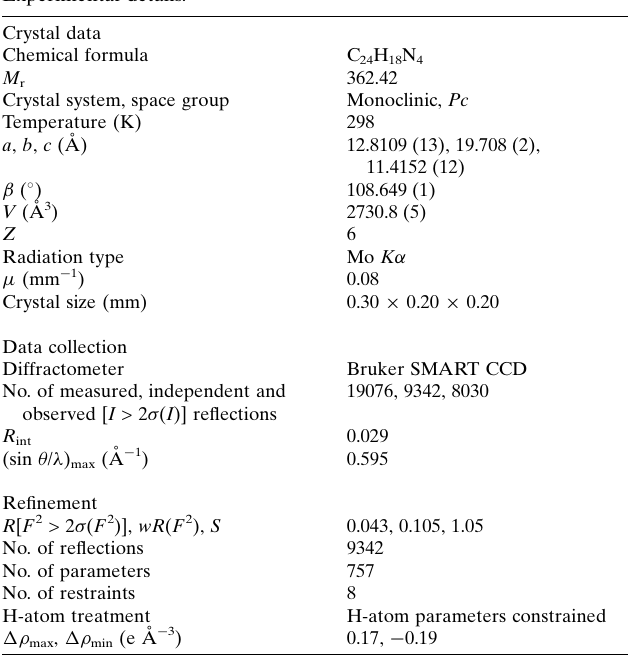
Table 2 Experimental details.